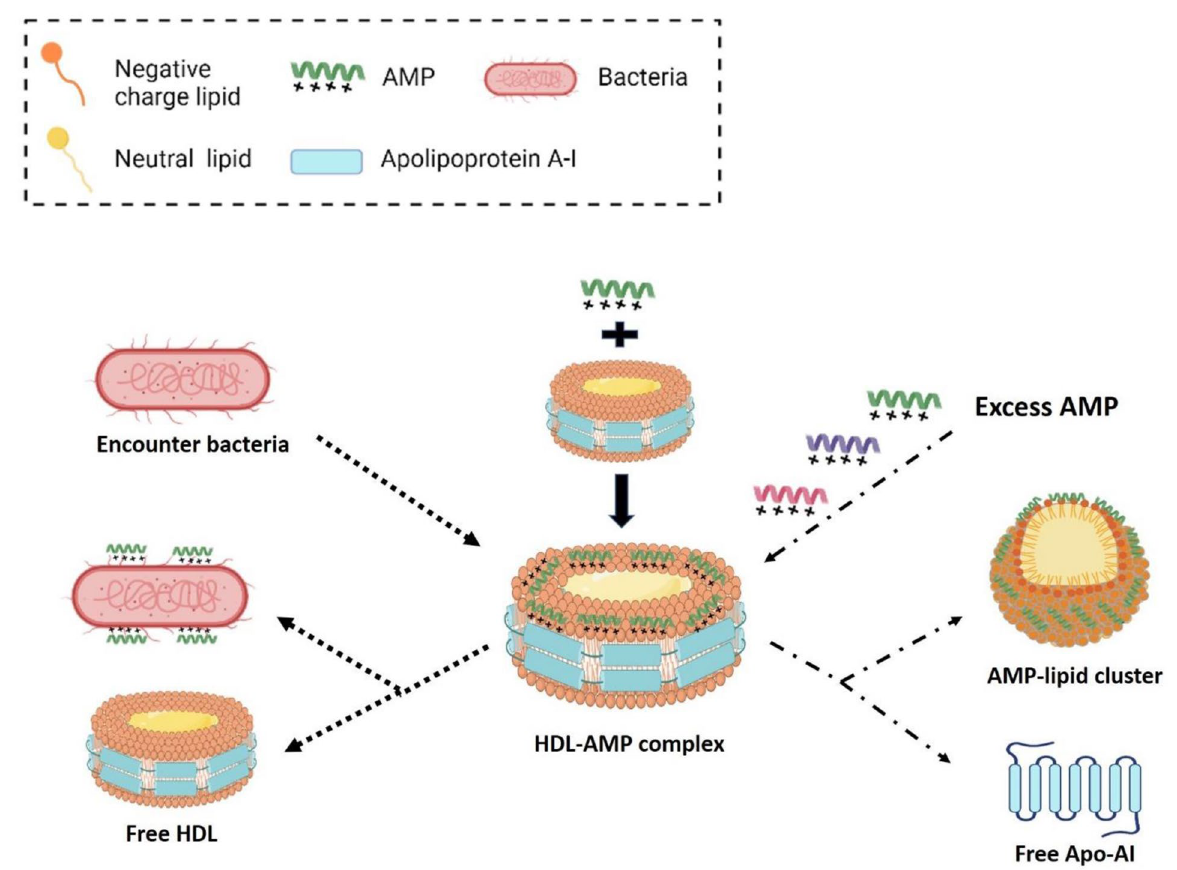
Figure 7. Model of interaction of HDL with AMP and bacteria. Neutral and negatively-charged lipids are assembled in a ring structure along with 8 amphipathic domains of Apo-AI through hydrophobic interaction. Cationic amphipathic AMPs are attached onto lipids mainly by hydrophobic interaction with various affinities. If excess amounts of AMP are embedded in the lipid clusters, the interaction between Apo-AI and lipid cluster of HDL may be weakened leading to the rupture or release of Apo-AI. In the presence of bacteria, the weaker- bound AMPs will dissociate from the AMP-HDL complex and attack to